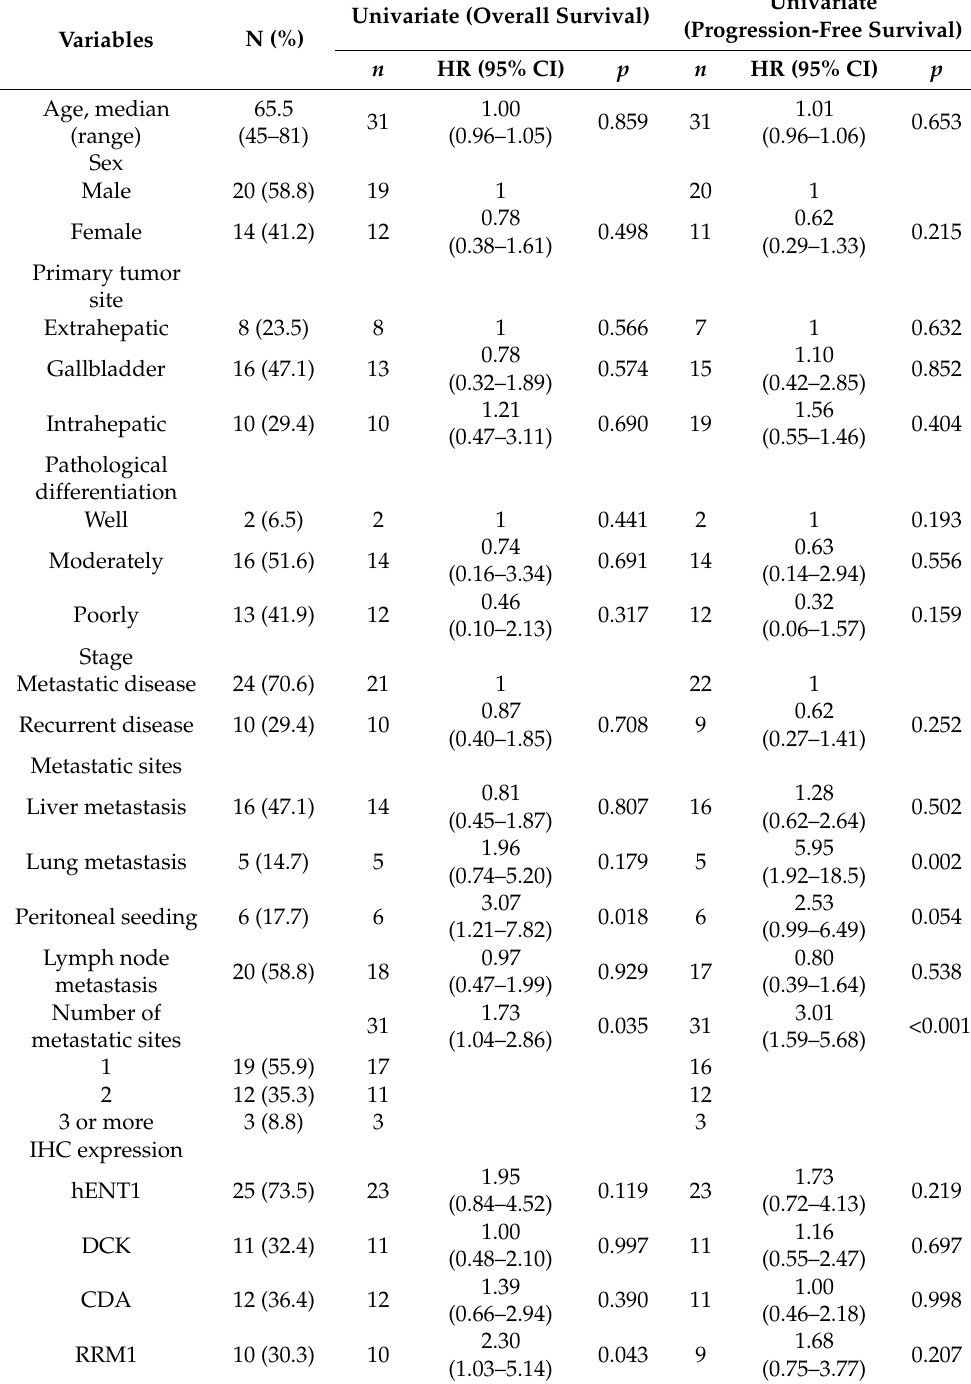
Table 1. Clinicopathological characteristics and univariate analysis of survival